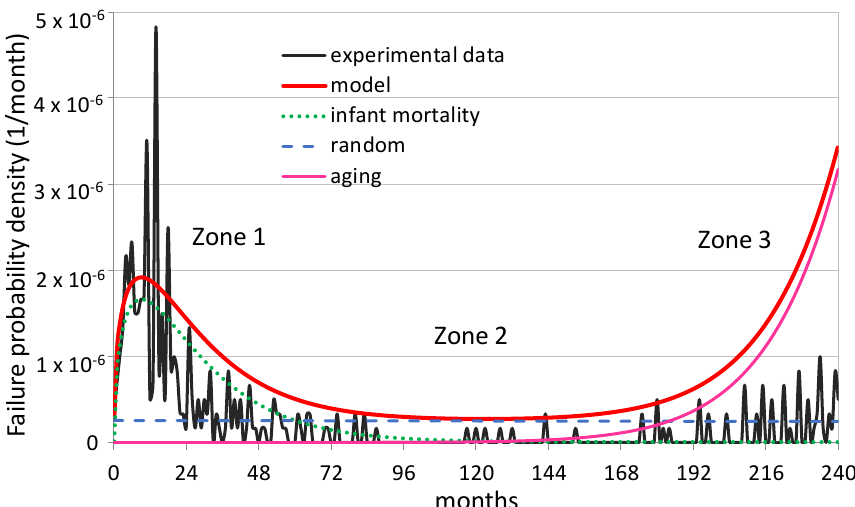
Figure 1. Typical shape of the experimental failure rate that can be subdivided into three zones: infant mortality (1), random failure (2) and aging (3).